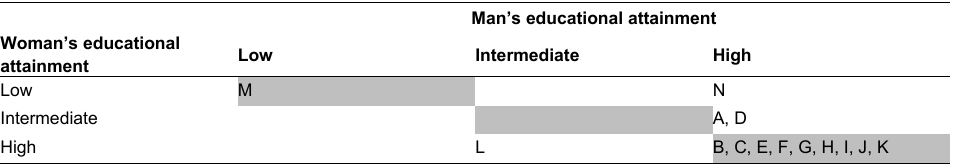
Table 2 : Educational degrees at the couple